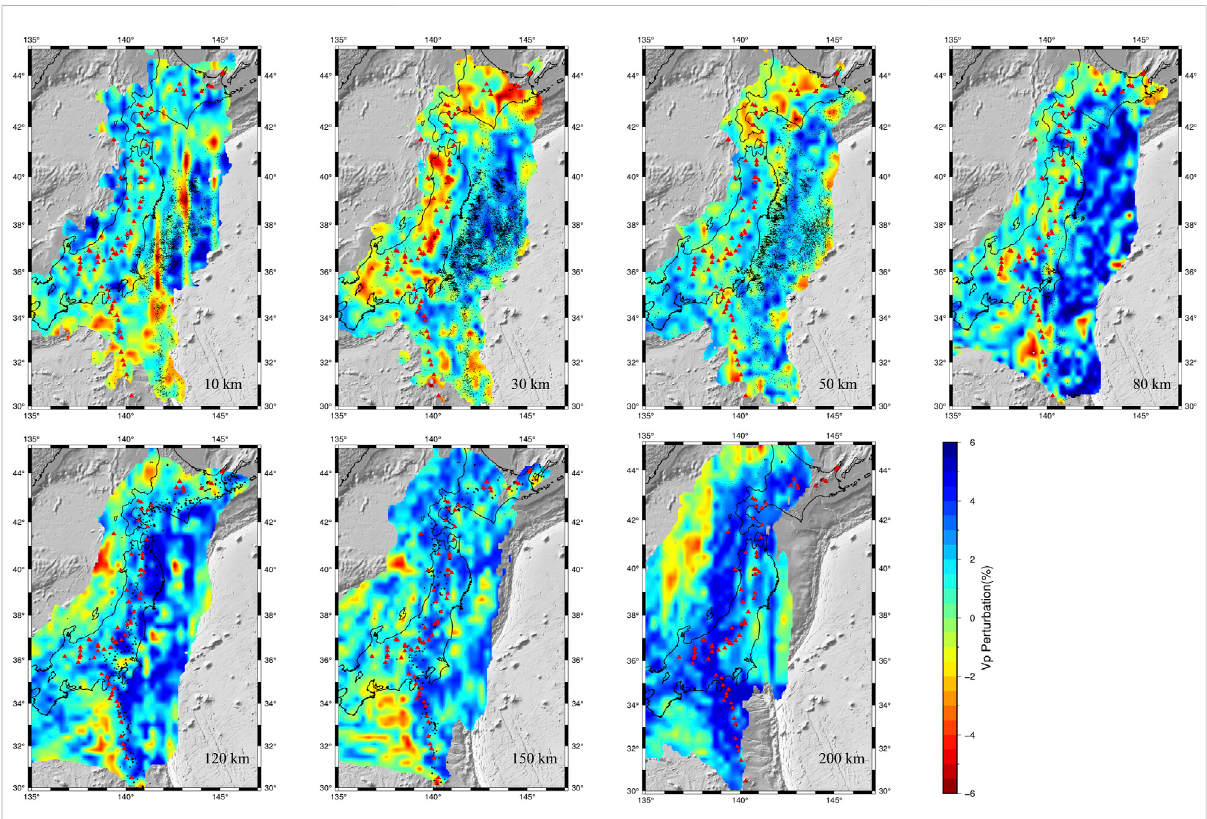
FIGURE 8 Map views of Vp structures. Black circles denote the background earthquakes that occurred within a layer of 30 km thickness bound to each slice. The red triangles denote the active arc